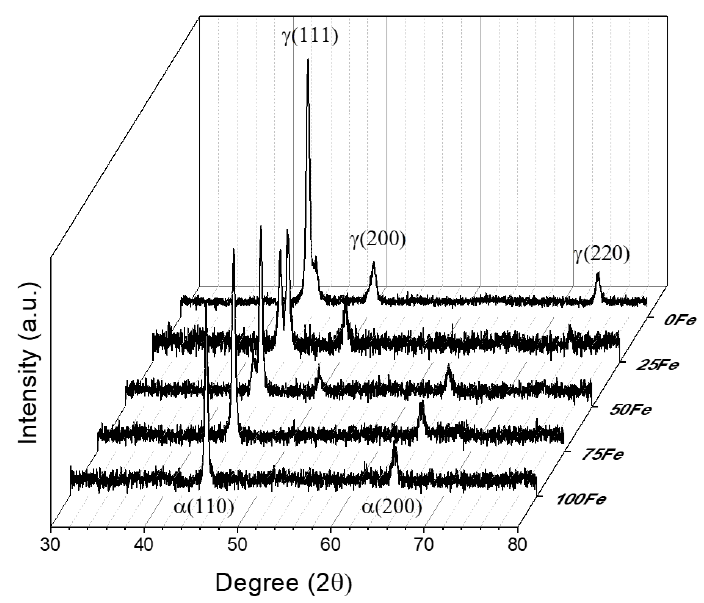
Figure 16. X-ray diffractometer (XRD) patterns at different layer along the composition gradient obtained for sample 2.